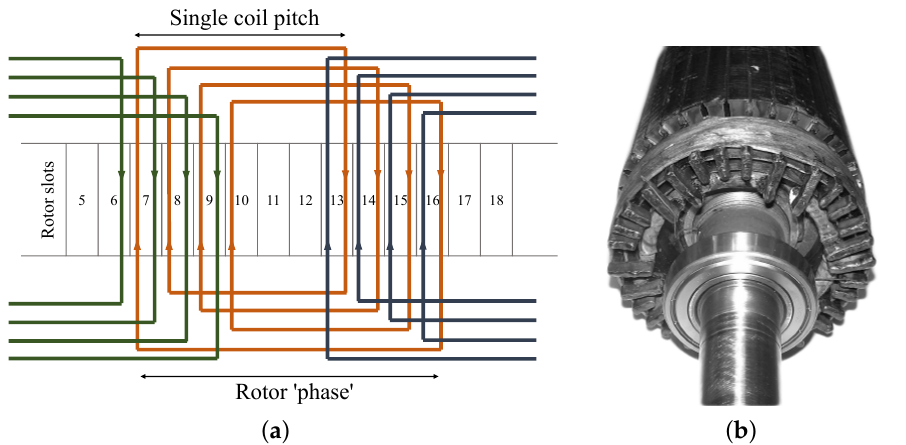
Figure 10. Double layer bar rotor: ( a ) Winding arrangement for p 1 / p 2 = 2/4, and ( b ) prototype [30].